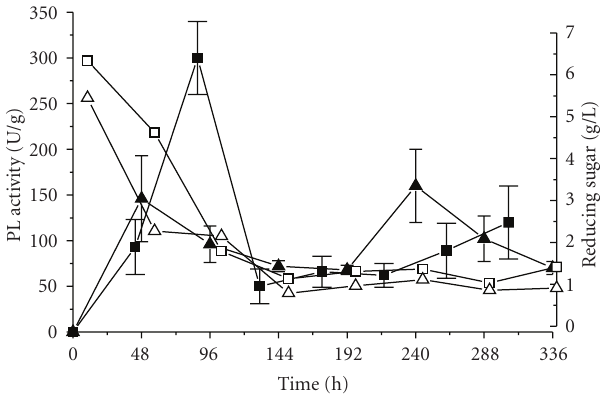
Figure 1: PL production by P. viridicatum RFC3 in solid state fermentation (SSF), using mixtures (w/w) of wheat bran and orange bagasse 1:1 ( PL activity; reducing sugar) or wheat bran, orange bagasse and sugarcane bagasse 1:1 :0.5 ( = PL activity; = reducing